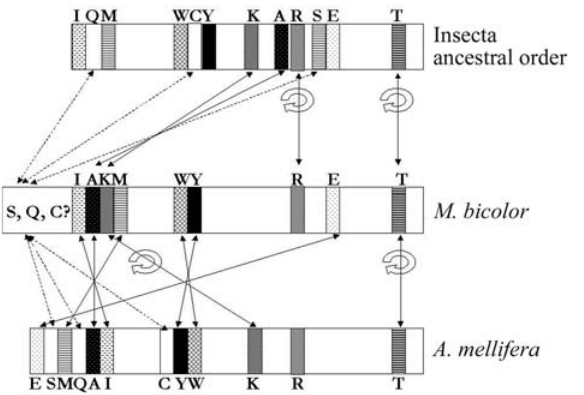
Figure 1 - Schematic representation of mitochondrial tRNA gene rear- rangements between Apis mellifera and Melipona bicolor . Only tRNA genes presenting a different gene order are represented. The putative an- cestral gene order of Insecta (Boore, 1999) is also represented here for comparison. Each gene is identified by the letters of the universal code of the amino acid carried by the correspondent tRNA. The thin solid arrows indicate translocations, and the thick circular arrows are symbols of strand inversions. The dotted arrows indicate the possible positions of the tRNA genes not present in the sequenced portion of M. bicolor genome (S,Q and